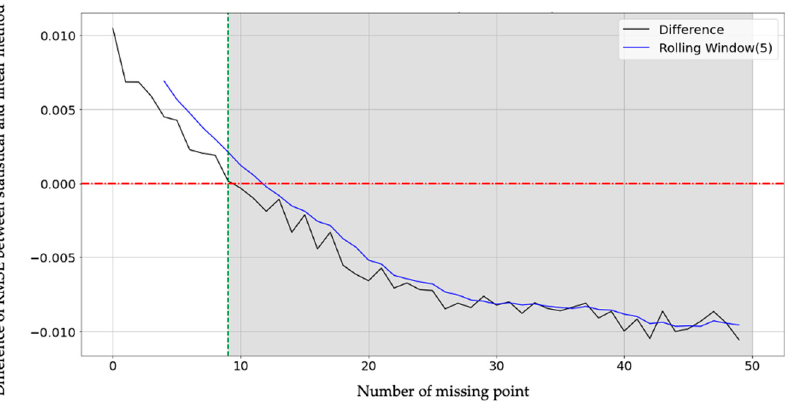
Figure 2. Difference of RMSE between statistical and linear imputation as the number of missing values increases.